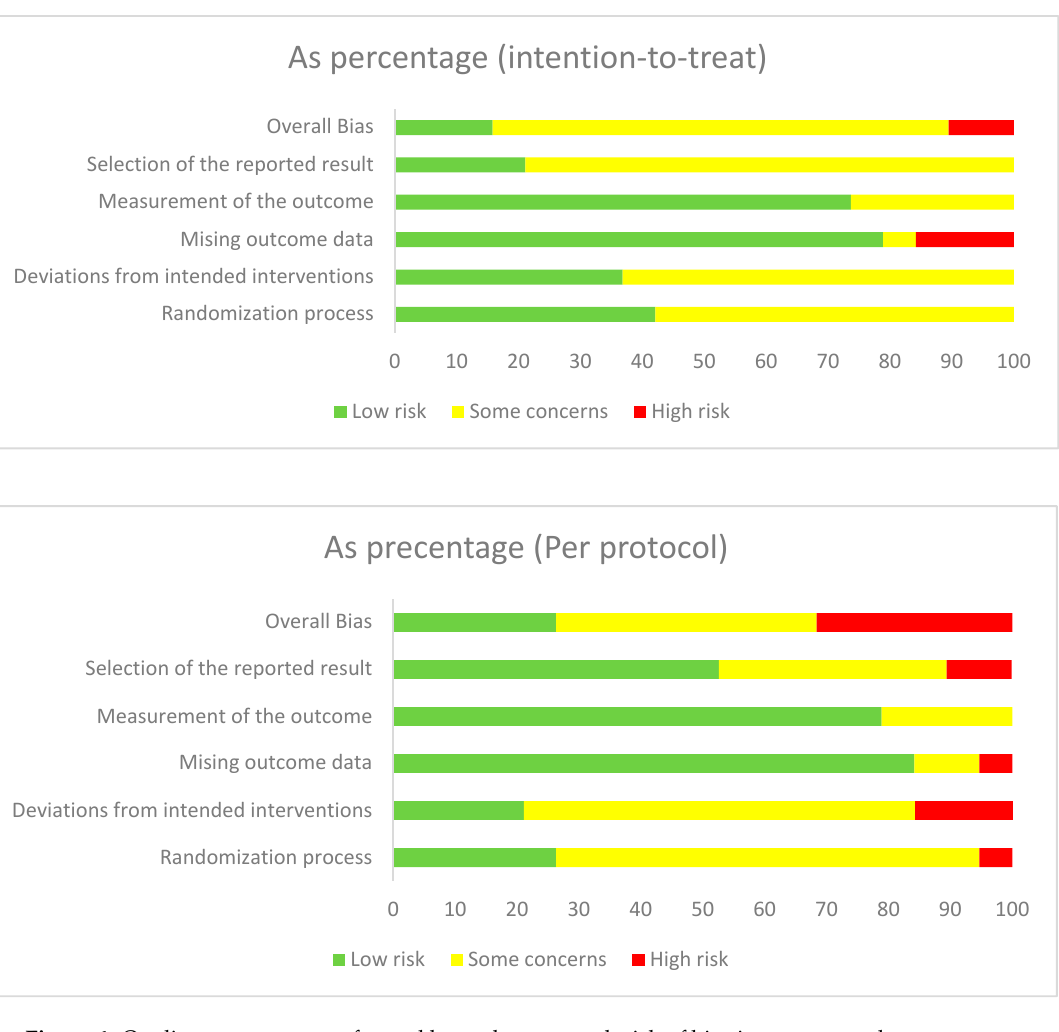
Figure 4. Quality assessment performed by authors on each risk of bias item presented as percentage across all included studies.